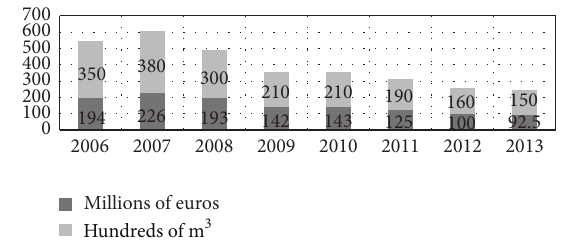
Figure 2: Total sales and production of insulating mineral wools in Spain from 2006 to 2013